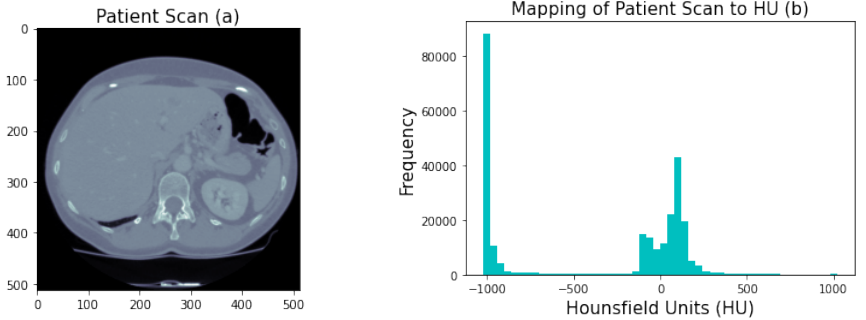
Figure 2. CT-Scan plot from ‘ PATIENT_DICOM ’ ( a ) and corresponding histogram of HU values ( b ).